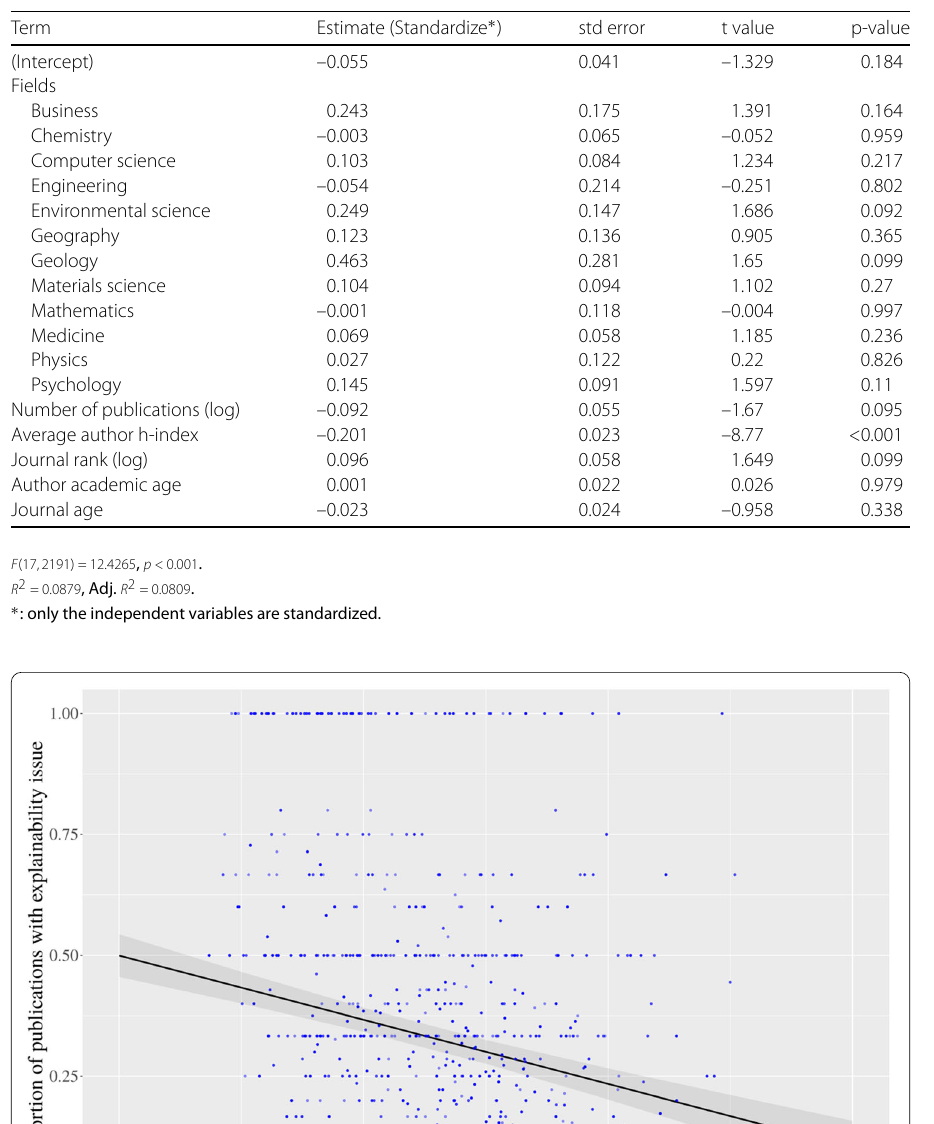
Table 4 Linear regression (standardized coefficients) on journals’ proportion of publications with explainability issues